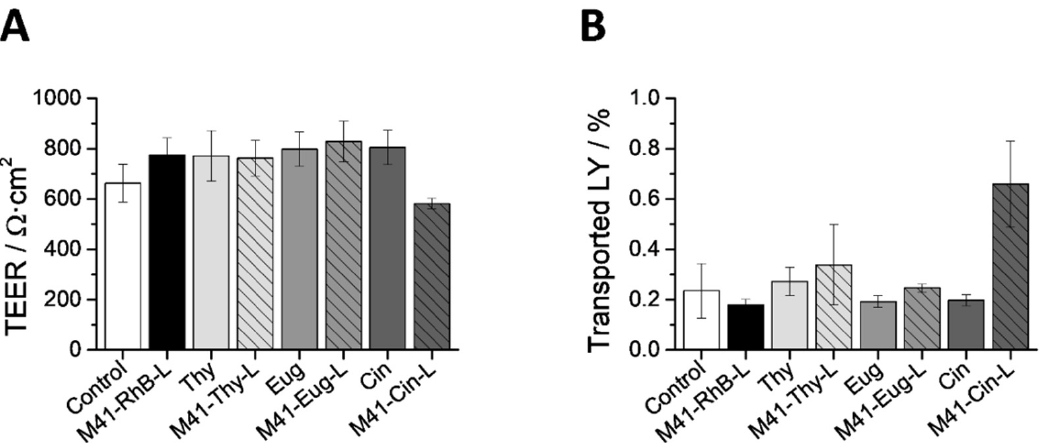
Figure 9. ( A ) TEER measurement values of non-treated intestinal barriers as negative control (white bar), treated with M41-RhB-L non-active microdevice as positive control (black bar) and intestinal barriers after 24 h of exposure to free EOCs (solid bars) or encapsulated into the M41-EOC-L microdevices (striped bars). ( B ) Transported LY (%) through the intestinal barrier after 24 h of exposure to free EOCs (solid bars) or encapsulated into the M41-EOC-L microdevices (striped bars) compared with non-treated membranes as negative control (white bar) or treated with M41-RhB-L (black bar). Data correspond to the average of three different experiments measured in triplicate, and error bars represent their standard deviation.